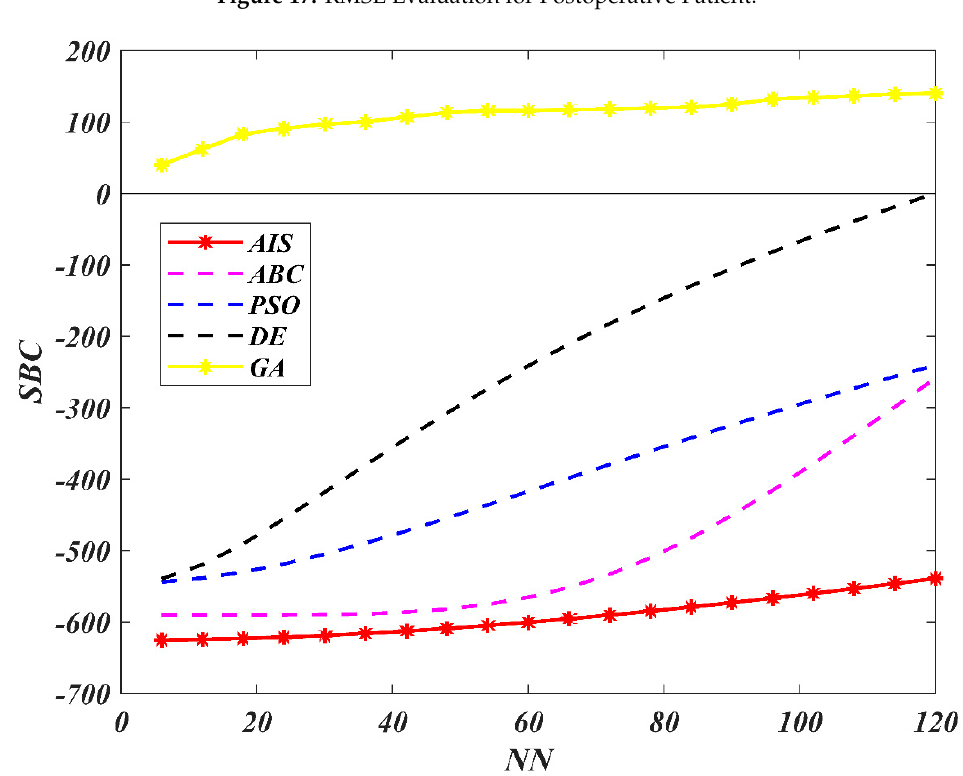
Figure 18. Schwarz Bayesian Criterion (SBC) Evaluation for German Credit.